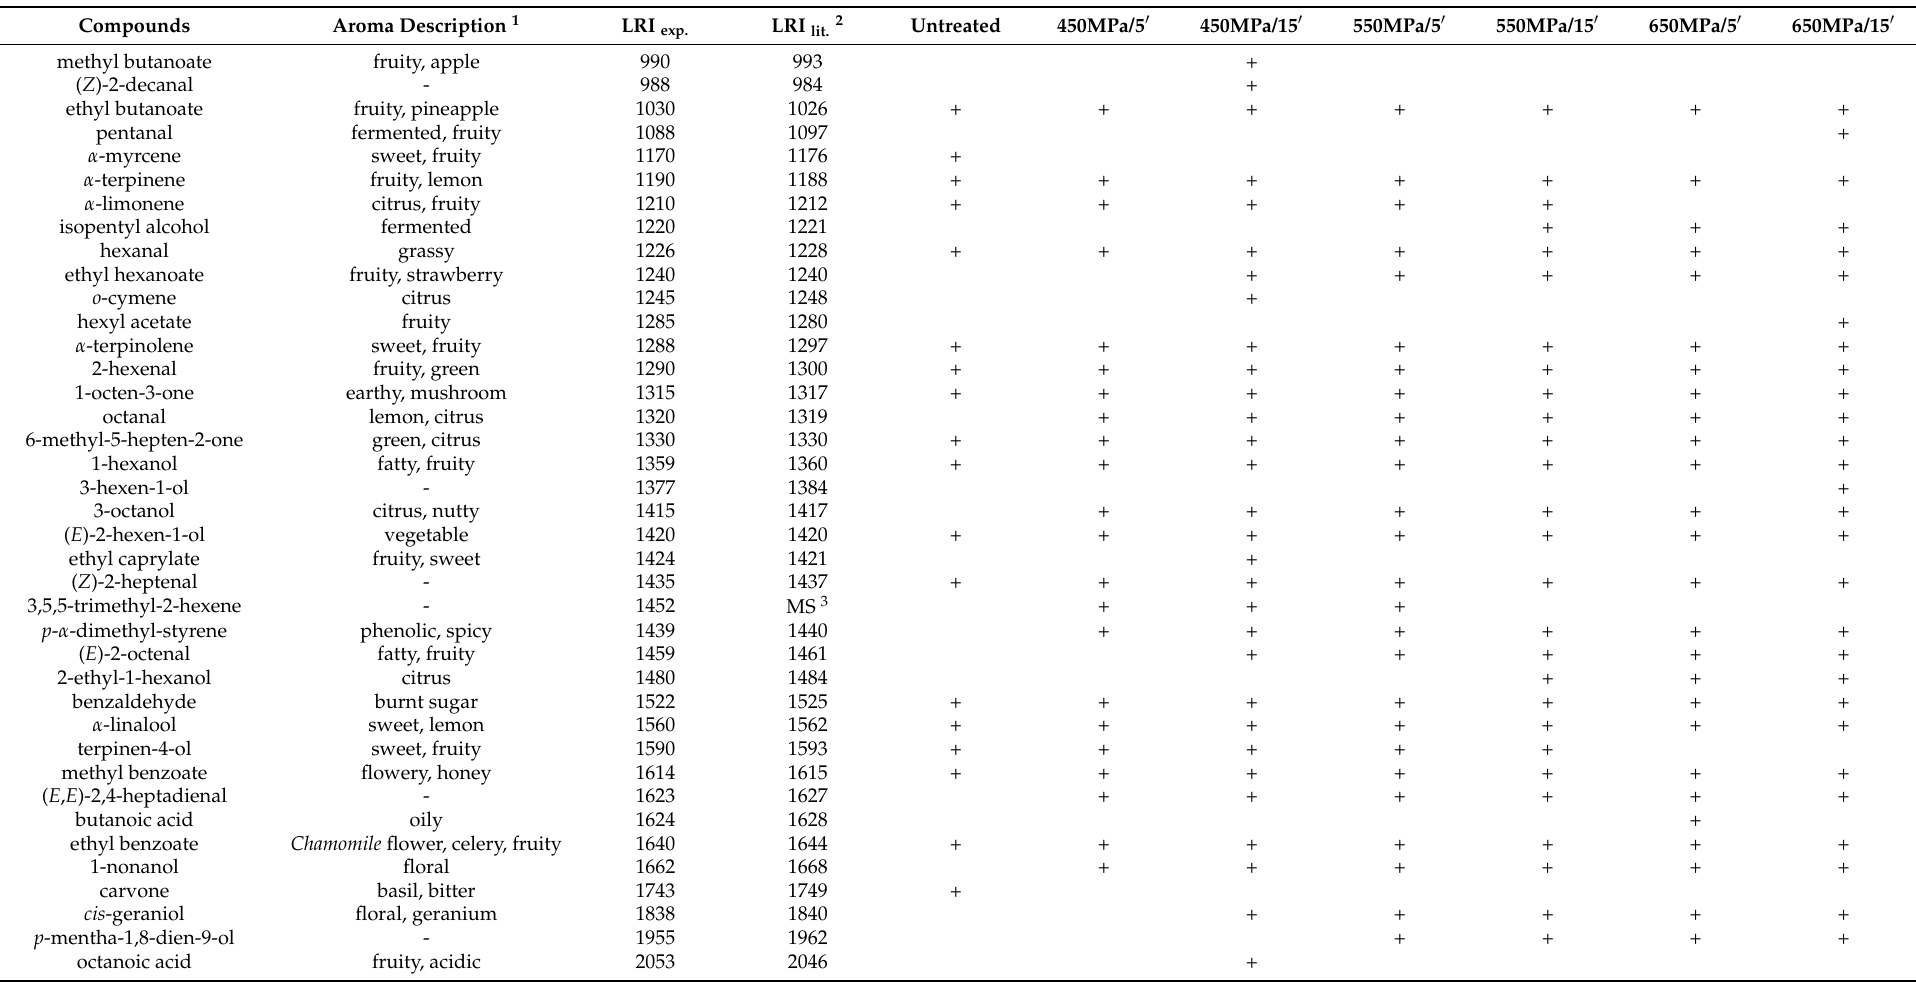
Table 1. Volatile organic compounds (VOCs) identified in the untreated and the HHP-treated (450–550–650 MPa/5 and 15 min) cv Geneva. VOCs are listed according to the experimental linear retention indices (LRI exp.